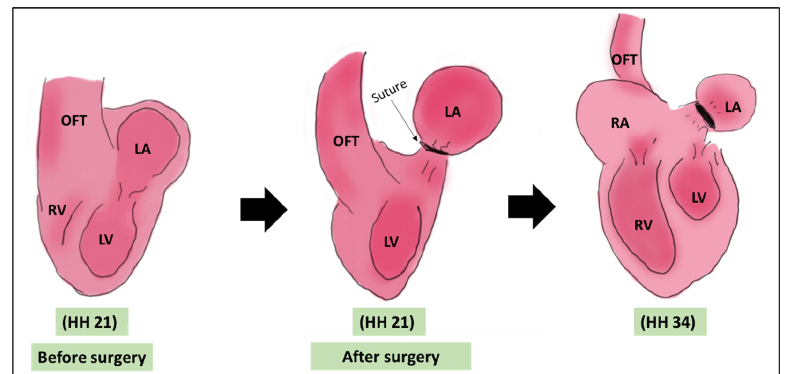
Figure 1. A schematic showing the LAL surgery. The surgery is done on HH 21 where a suture is tightened around the left atrium. The main morphological output of LAL is the underdeveloped LV [5,35]. OFT: outflow tract, LA: left atrium, LV: left ventricle, RA: right atrium, RV: right ventricle, HH: Hamburger & Hamilton.